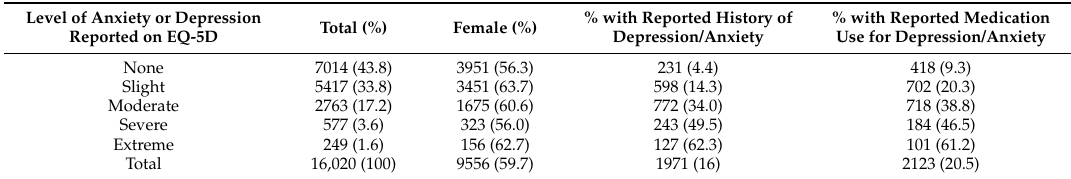
Table 1. Baseline demographics and self-reported levels of anxiety and depression on European Quality of Life Five Dimensions